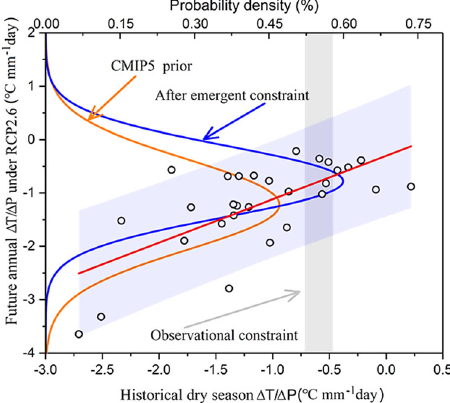
Fig. 2 Emergent constraint on the surface air temperature sensitivity to the precipitation. The outputs from the 29 models of the CMIP5 under RCP2.6 are used to derive the linear regression relationship between the future annual temperature sensitivity during 2006 – 2098 (see left y -axis) and the historical seasonal temperature (dry season) sensitivity during 1949 – 2002 (see bottom x -axis) ( y = (0.81 ± 0.17) x -0.30, p < 0.001, R = 0.68); Each model out- put is shown by a black circle; the grey shading is the observational constraint from the HadCRUT4 (observed value ± 1 standard error, − 0.58 ± 0.16 °C mm − 1 day). The blue shading is the 90% prediction error of the linear fi tting that has taken the fi tting errors into consideration; the orange and blue probability density functions (PDFs) are for the future annual temperature sensitivities before and after applying the emergent constraint, respectively. We assumed all models obey a Gaussian